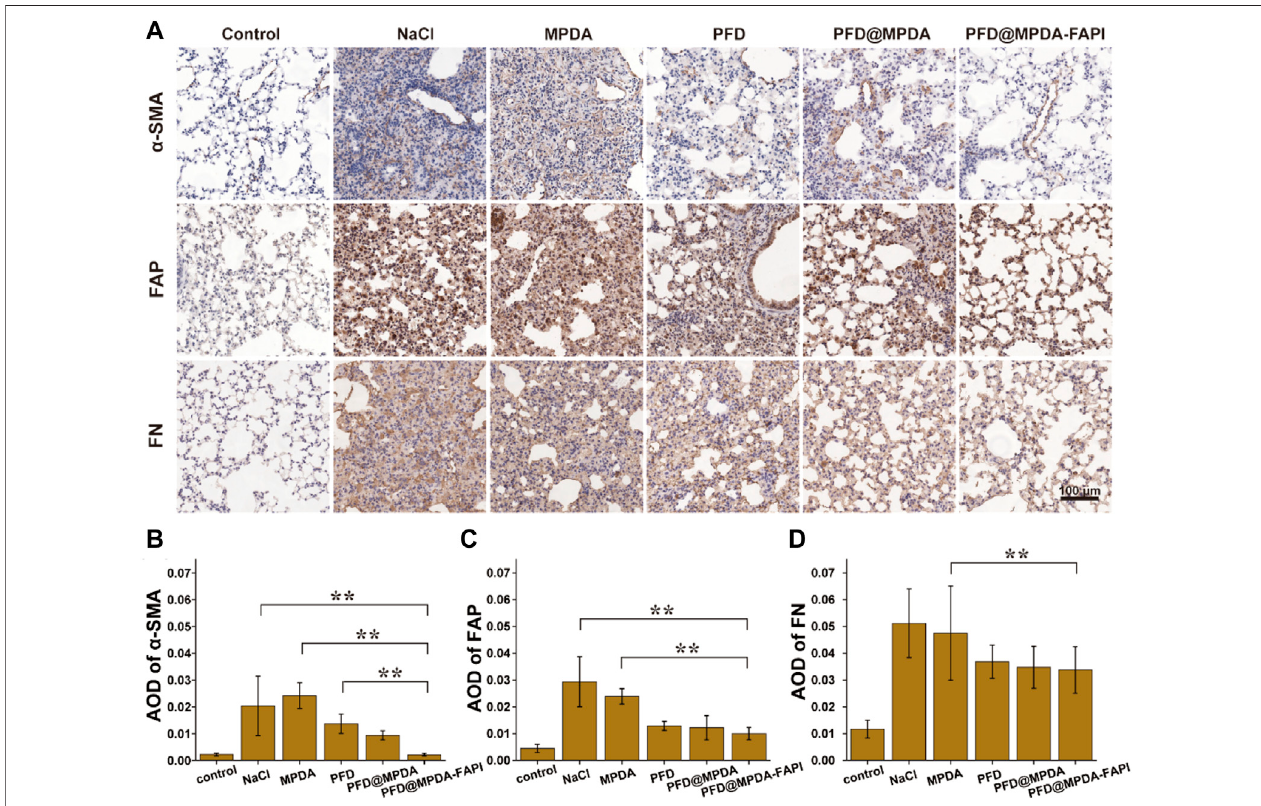
FIGURE 7 | (A) IHC staining for FN, FAP, and α -SMA among different treatment groups. (B – D) AOD of IHC staining for FN, FAP, and α -SMA among different treatment groups.